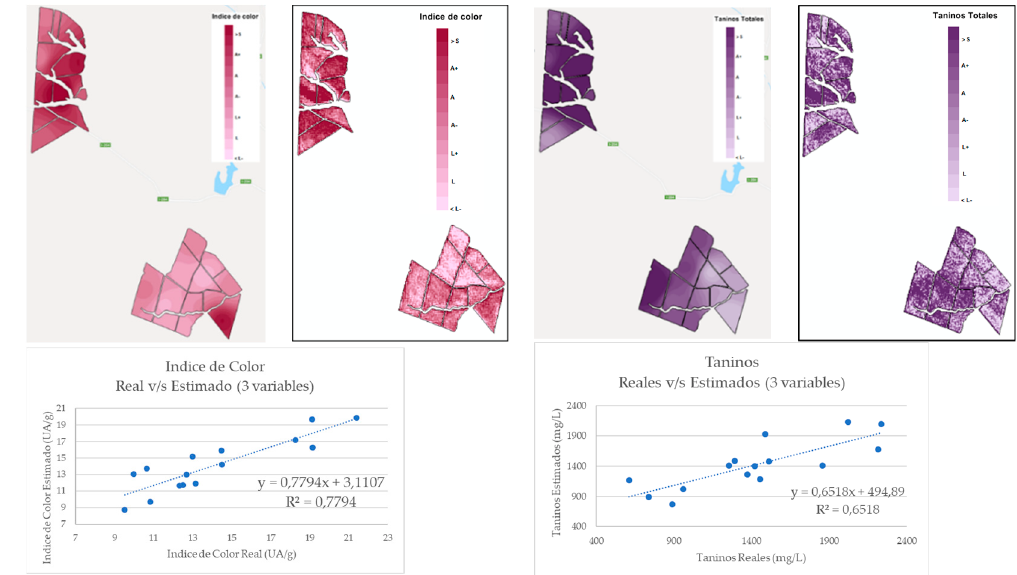
Figure 1. Comparison between real maps and maps modeled from a multiple linear regression function. The example shows only two results: Color Index and